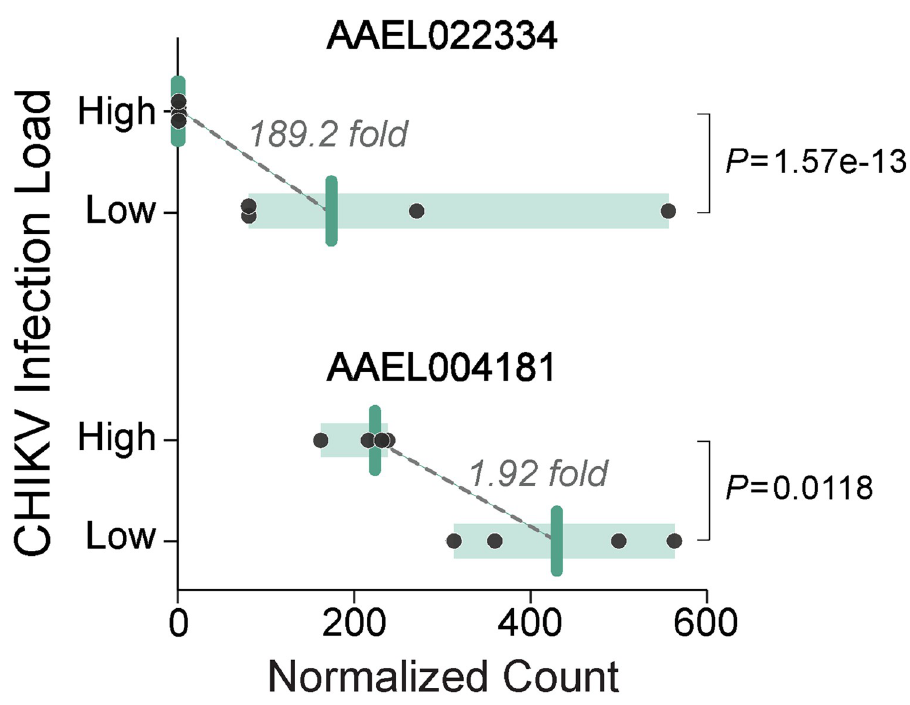
Fig 4. RNAseq counts for the two loci with significant expression differences between high and low CHIKV-load families. Points depict normalized read counts of individual families, bars show group medians, and shaded area demarcates the range for each group. Significance was evaluated using Wald tests while correcting for multiple